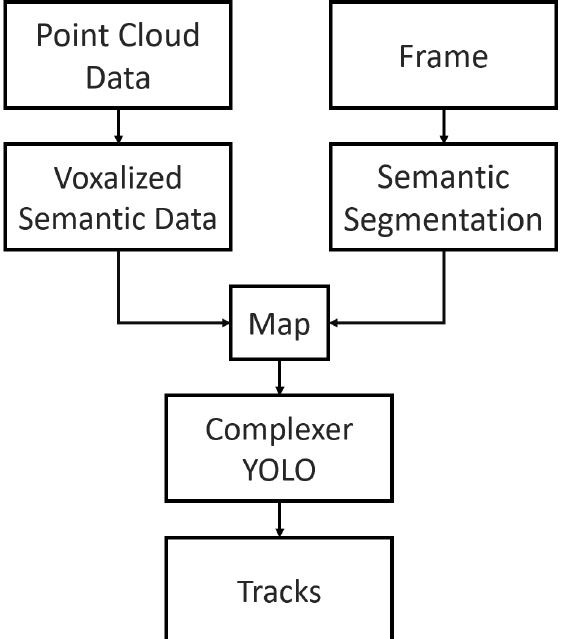
Figure 8. Complexer-YOLO [85]. Data from RGB frame and point cloud data are mapped and passed into Complexer-YOLO for tracking and matching.